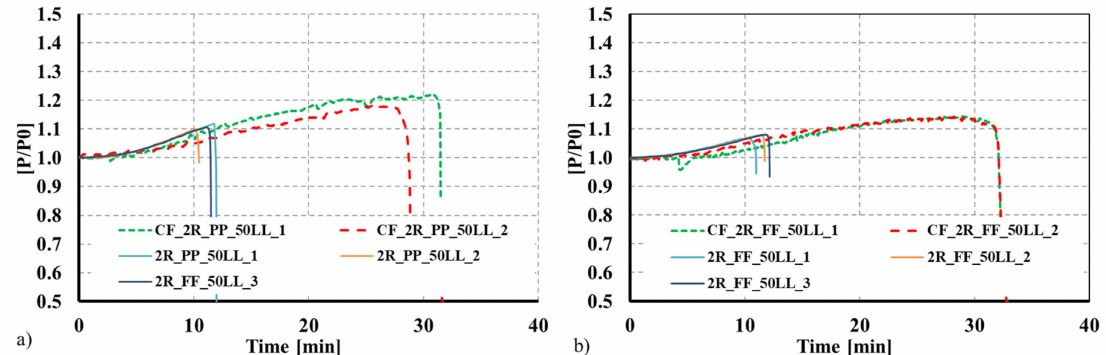
Figure 11. Comparison between bare steel R columns and concrete-filled CFS R columns as a function of time. ( a ) Pinned columns. ( b ) Fixed